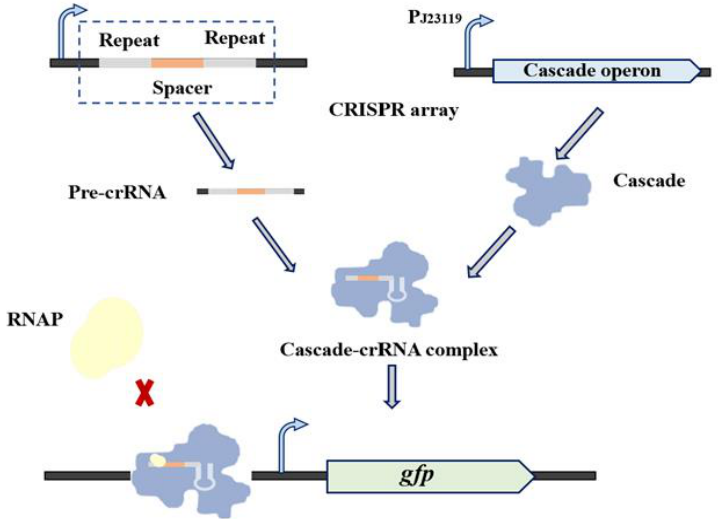
Figure 5. The light-controlled CRISPR system regulates the metabolic pathway of PHB production. The crRNA was expressed on a plasmid and Cascade was activated for expression with the constitutive promoter J23119. This Cascade mediates the maturation of crRNA and forms a complex with crRNA to target gene sites, thus, disturbing transcription.